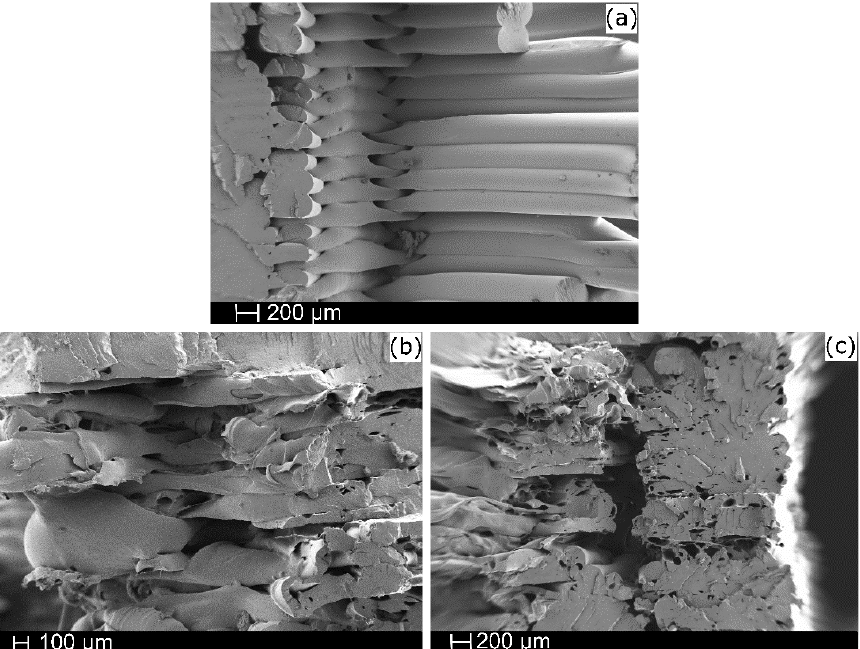
Figure 6. SEM microstructural characterization of ( a ) neat PLA, ( b ) PLA-3%, and ( c ) PLA-5%.